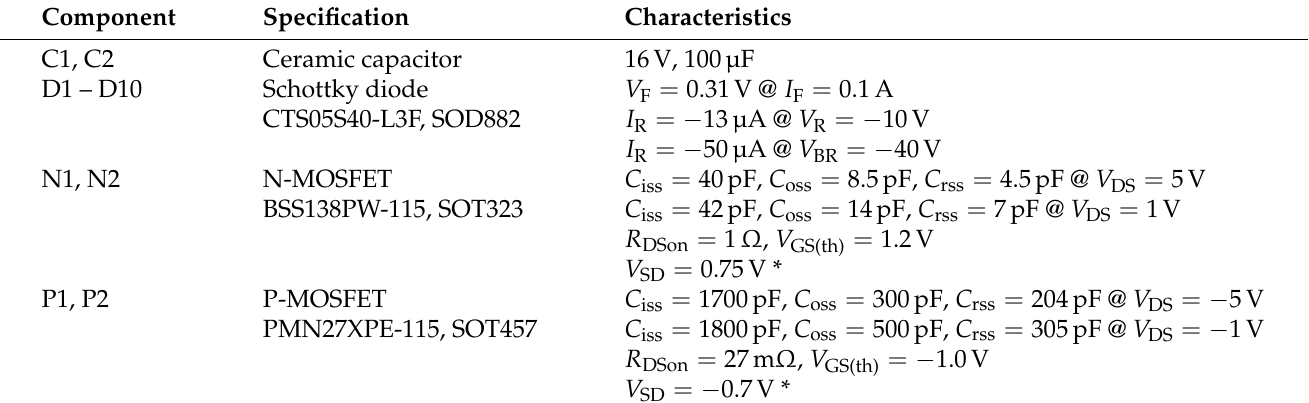
Table 2. Specification of key components for the rectifier circuit implementations.